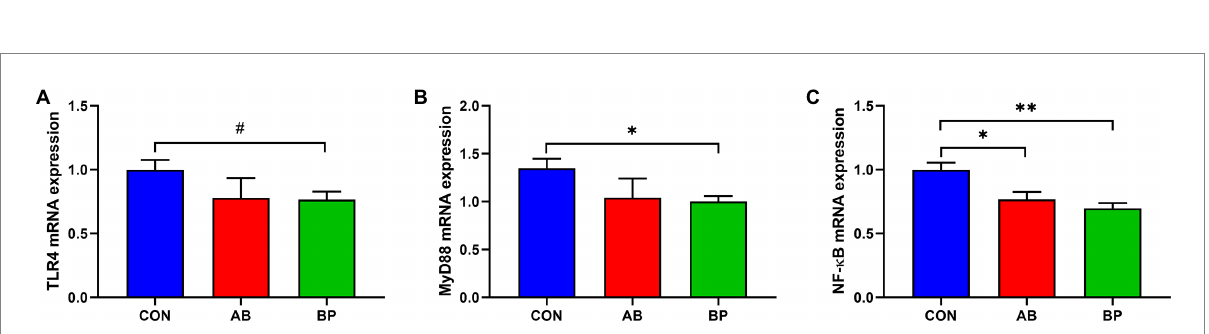
FIGURE 8 Effects of dietary supplemented with Bopu powder on expressions of inflammatory genes in intestine of broiler chickens. (A) Toll-like receptor 4 ( TLR4 ); (B) Myeloid differentiation primary response 88 ( MyD88 ); and (C) Nuclear factor-kappa B ( NF- κ B ). CON group, broiler chickens fed a basal diet; AB group, broiler chickens fed a basal diet supplemented with 50 mg/kg aureomycin; BP group, broiler chickens fed a basal diet supplemented with 40 mg/kg Bopu powder containing protopine and allocryptopine. Values are mean ± standard error ( n = 6). # 0.05 ≤ p < 0.10, * p < 0.05, ** p <